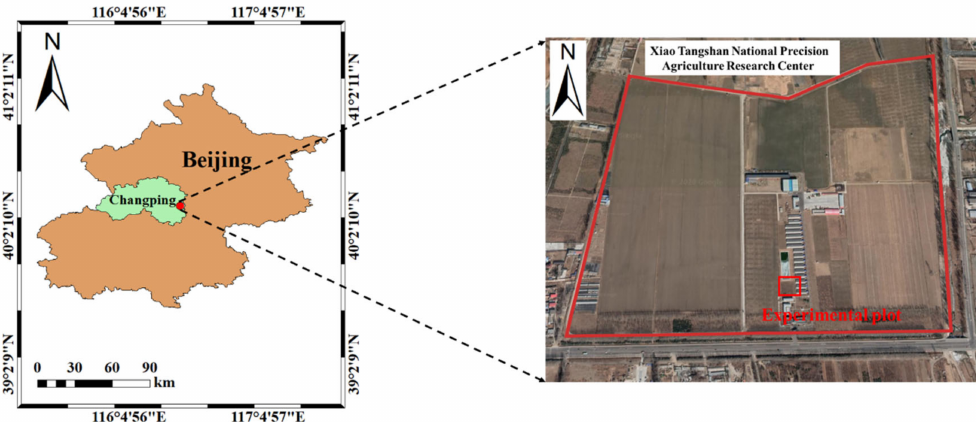
Figure 1. Location of experimental